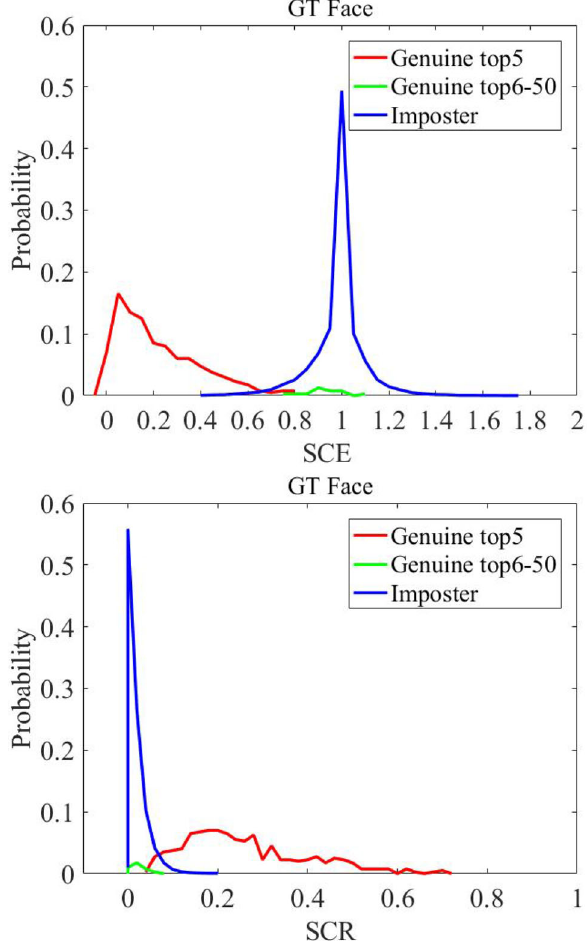
Fig. 4 Two instances of SCE scores obtained in the face subset of MD II client and non-target subjects. SRC-based verification pro- vides a competing mechanism, i.e., sparse coding optimiza-